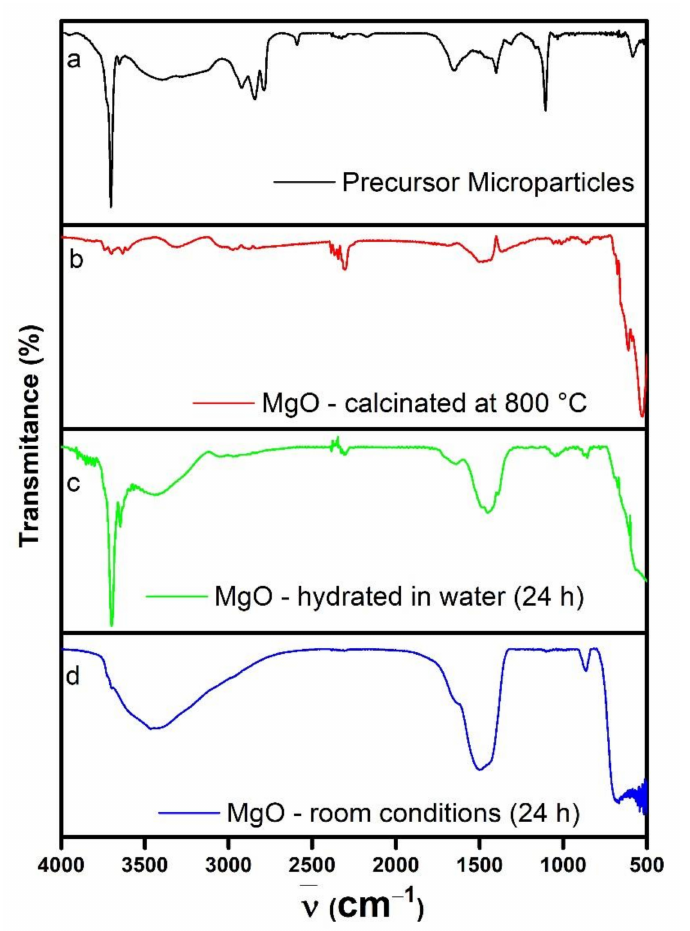
Figure 7. Fourier-transform infrared (FTIR) transmittance spectra of the PM before the calcination ( a ), MgO nanoparticles just after the calcination at 800 ◦ C ( b ), the MgO nanoparticles hydrated in water for 24 h ( c ), and the MgO nanoparticles stored under room conditions for 24 h ( d